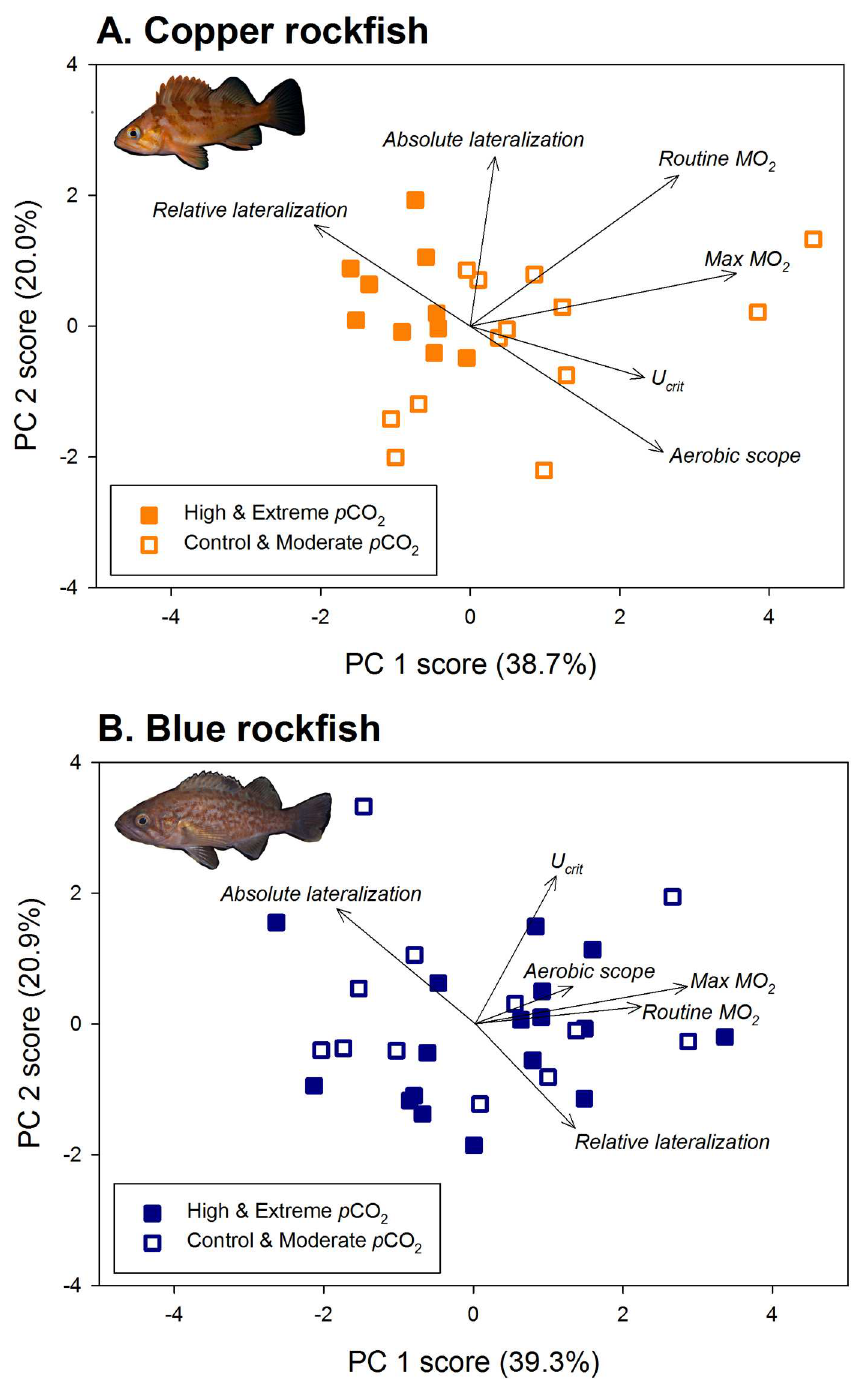
Fig 2. Principal components analysis depicting correlations amongst the suite of behavioral and physiological performance variables measuredfor (A) copper rockfish and (B) blue rockfish throughout the course of the experiment as a function of p CO 2 exposure history. Filled symbols indicatefish from the two highest p CO 2 treatments and open symbols signify fish from the two lowest p CO 2 treatments. Fish were tagged to allowtracking of individualsacross all performance measuresand are plotted basedon their multivariate combinedperformancehistory in behavioral and physiological challenges.Axes show the percent of variationexplained by each